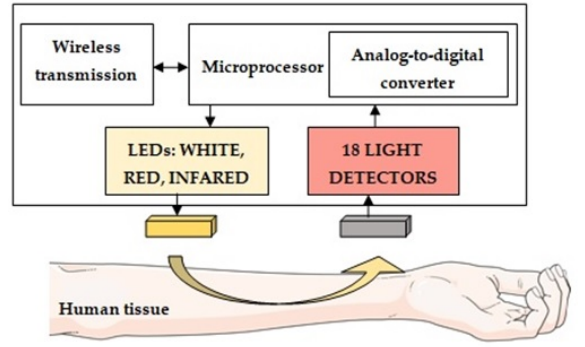
Figure 5. Multichannel spectrum analyzer architecture. Eighteen channels with laser radiation of various wavelengths are used for research.